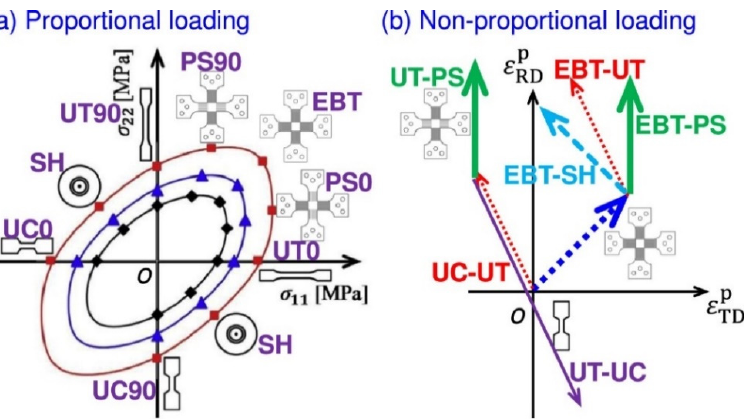
Figure 21. Mechanical characterization approaches used to investigate the evolving yield surfaces under ( a ) proportional loading and ( b ) non-proportional loading. Reprinted from Ref. [184] with permission. Copyright 2022, Elsevier.